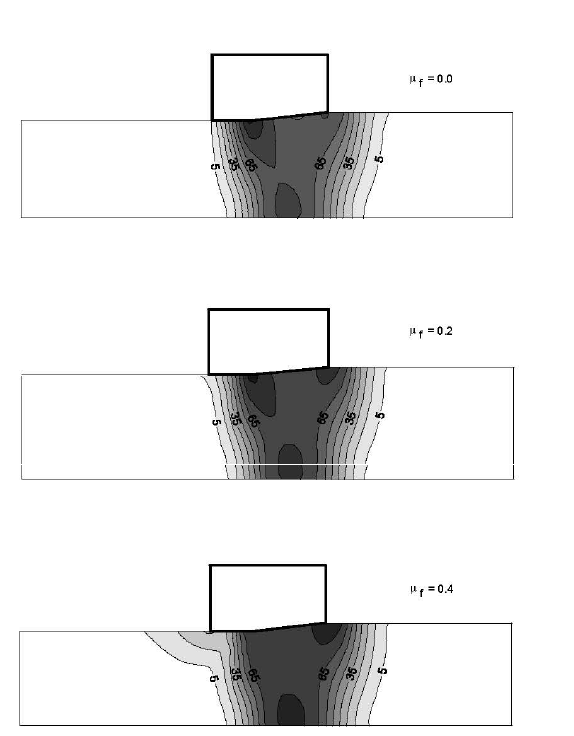
Fig. 6. Equivalent strain-rates at friction coefficients µ f = 0.0 , µ f = 0.2 and µ f = 0.4